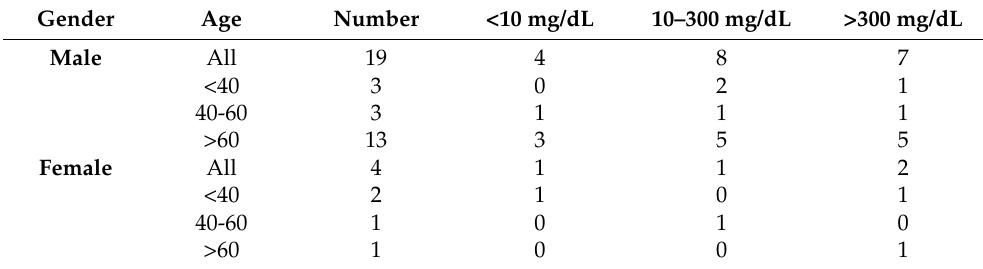
Table 1. Benchmark ACR values of urine samples collected from real-world CKD patients of different genders and ages.